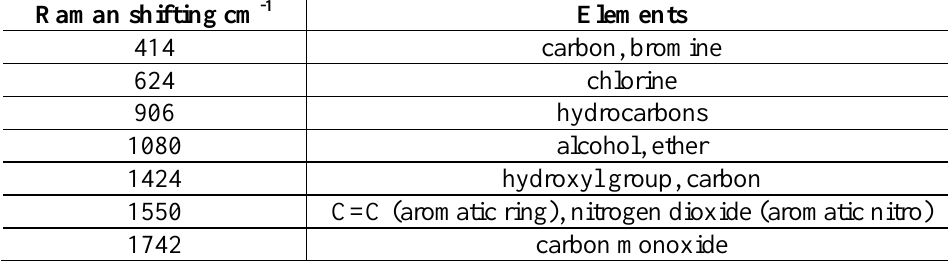
Figure 6: Absorption spectrum of dust pollutants. Table 1: Polluted elements by